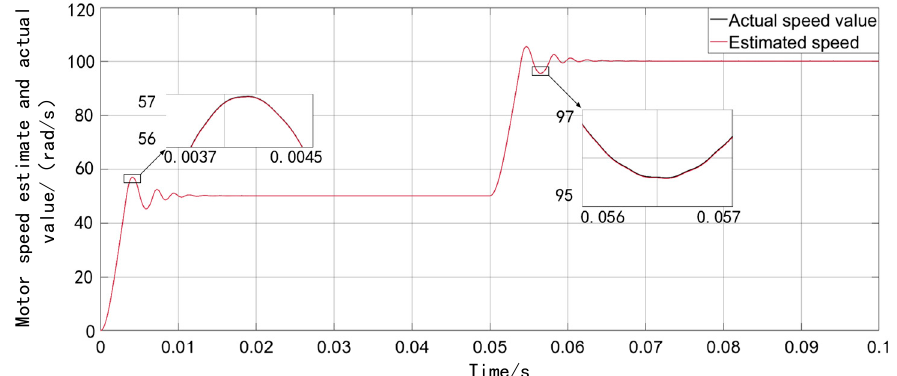
Figure 9. Comparison chart of motor speed of the new and improved SMO at high speed.